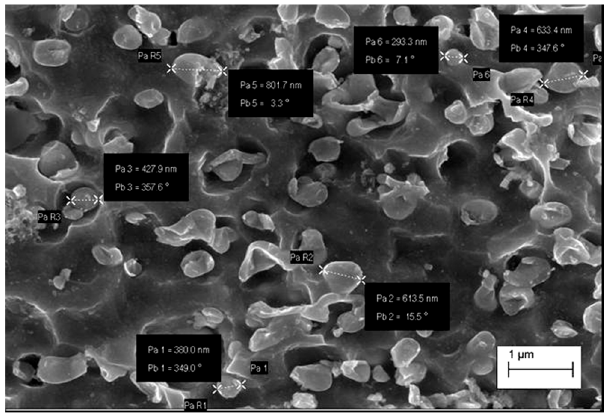
Figure 8. Structure of Cu–2Ni–1Si–0.6Re alloy: supersaturation 950 °C; time 1 h, water cooling (Ar); plastic deformation 50%; ageing 450 °C 1 h.